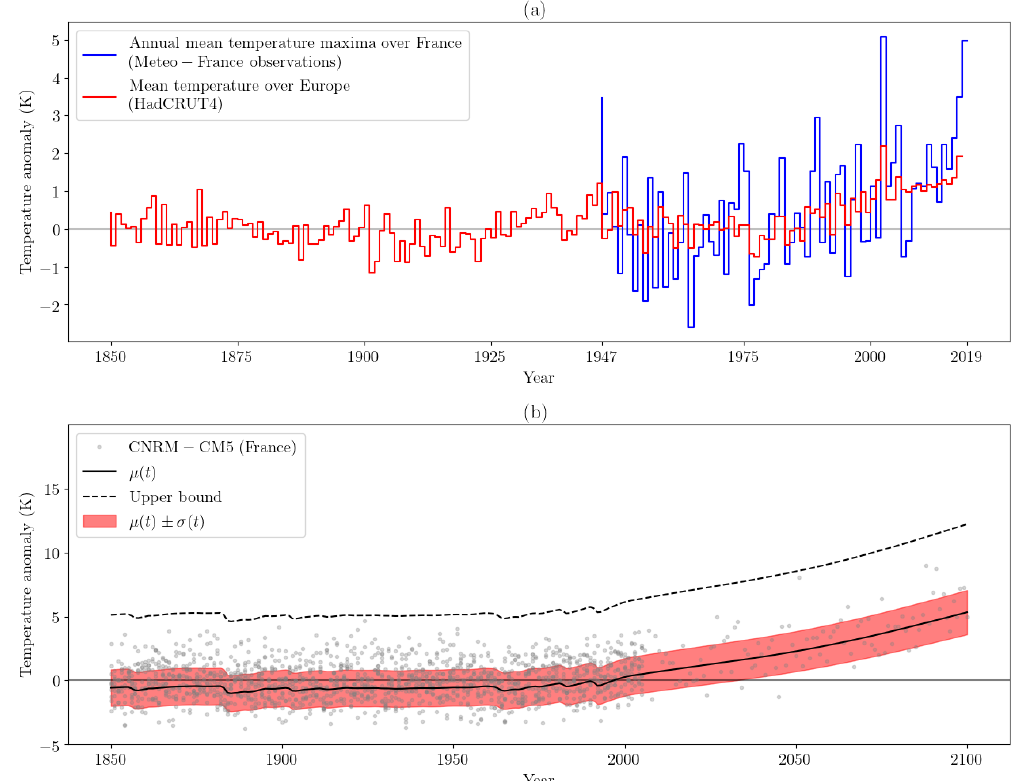
Figure 1. (a) The red line shows the average of the mean temperature anomaly (with respect to 1961–1990) over Europe (35–70 ◦ N, 10 ◦ W– 30 ◦ E), between 1850 and 2019, extracted from HadCRUT4 (Jones et al., 1999, 2001, 2012; Kennedy et al., 2011; Morice et al., 2012). The blue line shows the annual maxima of the anomaly (with respect to 1961–1990) with a 3d moving average of thermal index over France, between 1947 and 2019 (30 stations over France, Météo-France data). (b) Example of a fit with a nonstationary GEV law (see Eq. 1) for the CNRM–CM5 model. The gray points are the values of the model over France. The black line is the location parameter µ ( t ). The red shading shows the scale parameters µ ( t ) ± σ ( t ). The dotted black line is the upper bound, i.e., µ ( t ) − σ ( t ) /ξ ( t ) if ξ ( t ) <